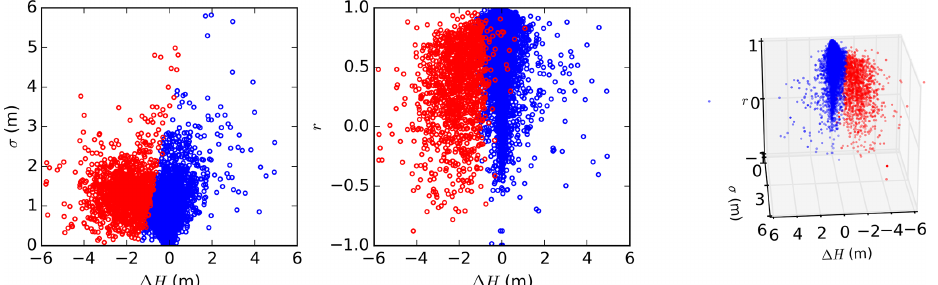
Figure 12. Classification of collapsed (red) and noncollapsed (blue) buildings using the three parameters based on the k -means clustering method.